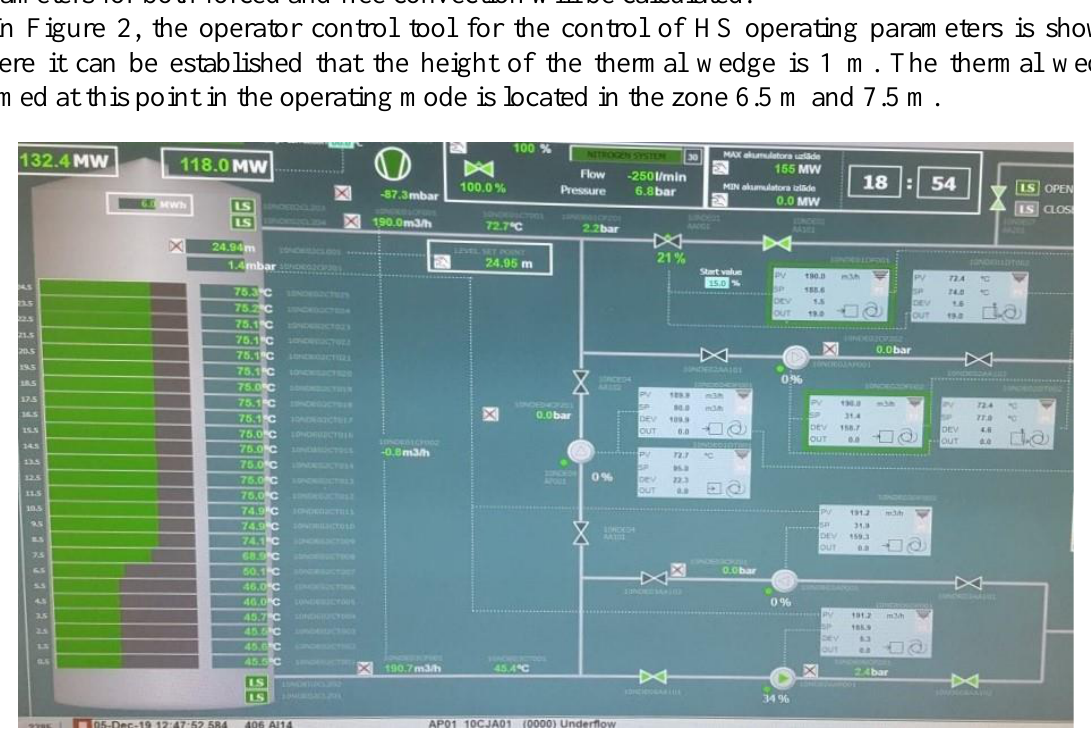
Figure 2. The end of charging cycle of the heat